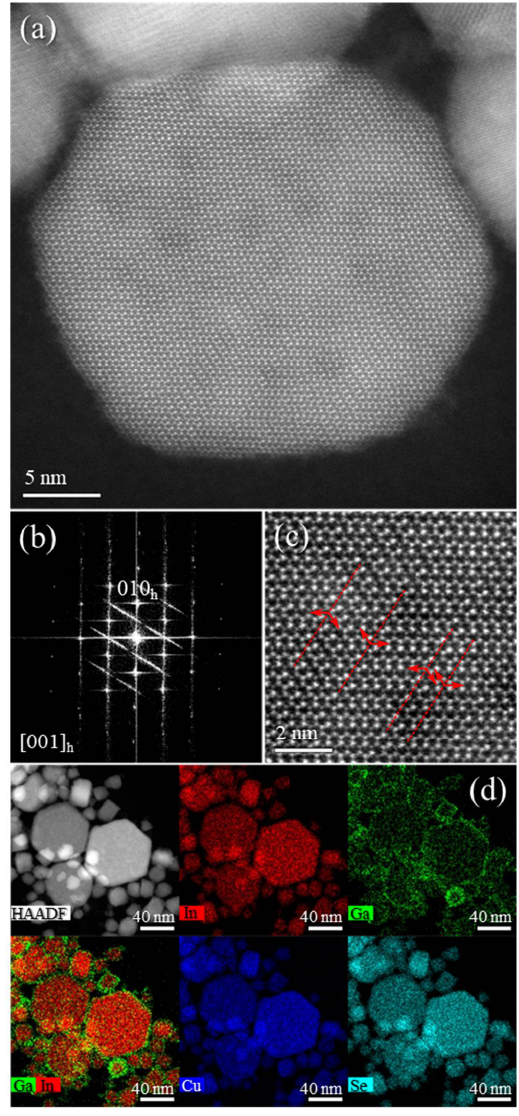
Figure 2. High-angle annular dark-field scanning transmission electron microscopy (HAADF– STEM) images ( a , c ), Fourier-transform (FFT) pattern ( b ), and STEM–energy-dispersive X-ray spec- troscopy (EDX) maps ( d ) of Sample II .